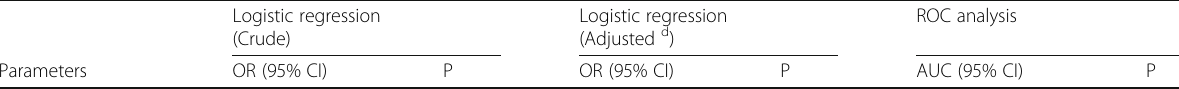
Table 3 Logistic regression and ROC analysis results